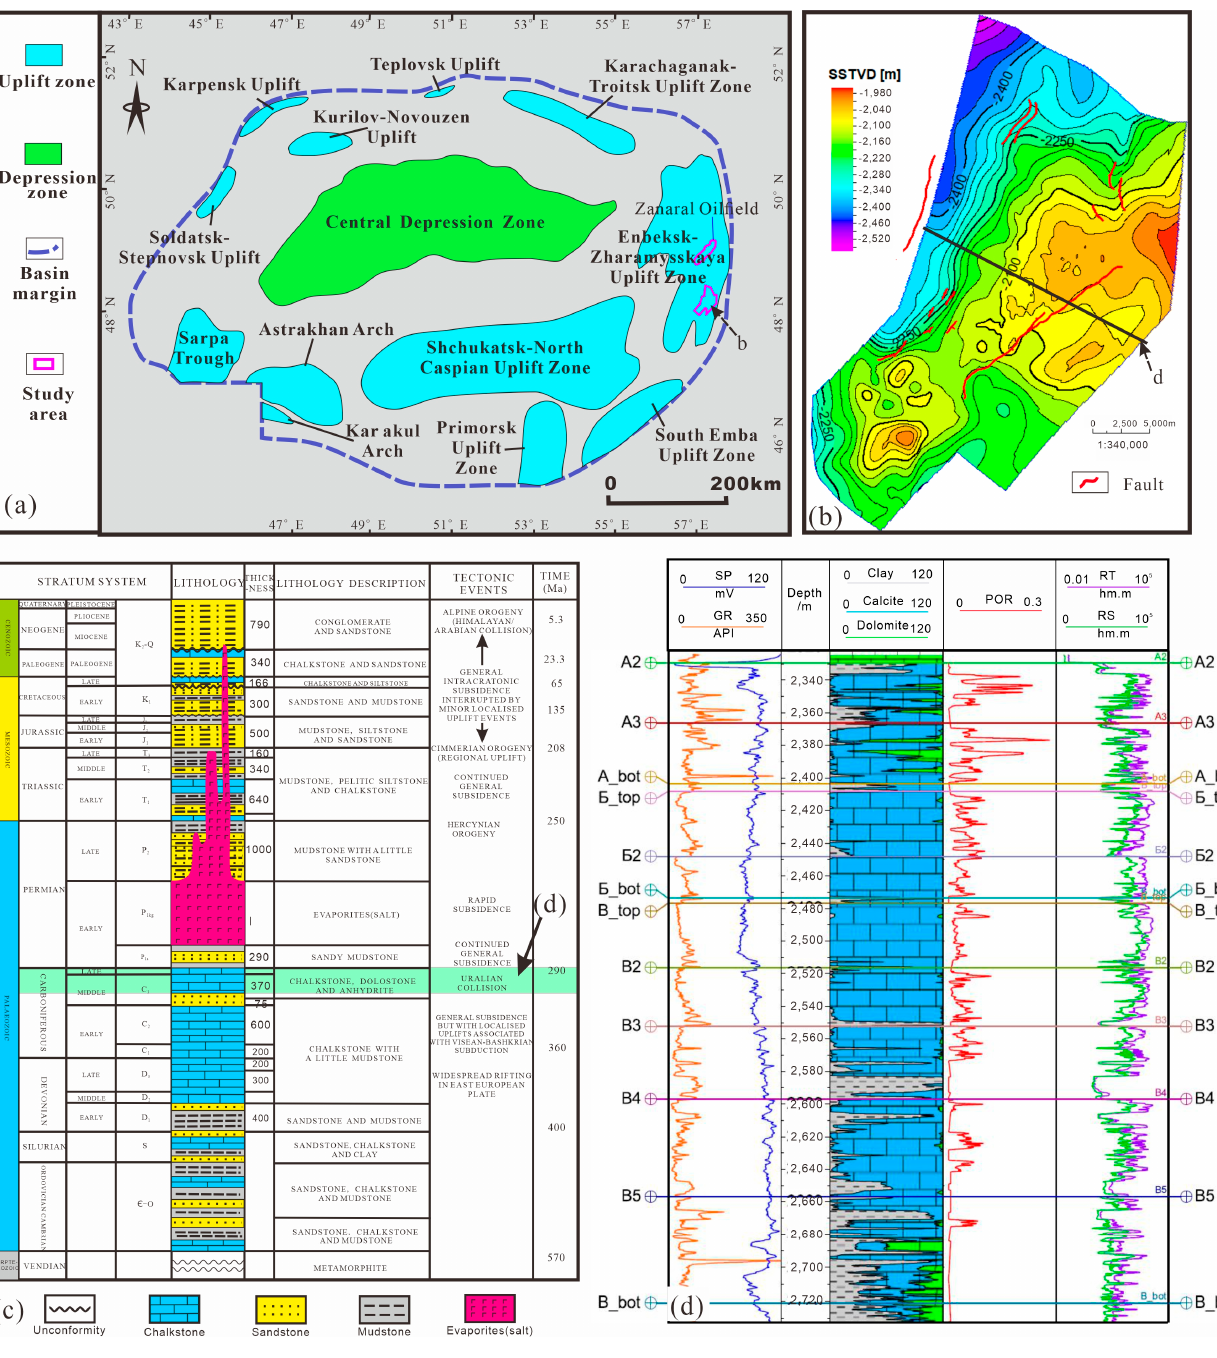
Figure 1. ( a ) Tectonic divisions of Precaspian Basin [23]. ( b ) The structural map of the top of the KT-I Formation. ( c ) Stratigraphic column for the area of study [24]. ( d ) The layer division results of the KT-I Formation in the NT oilfield [25].